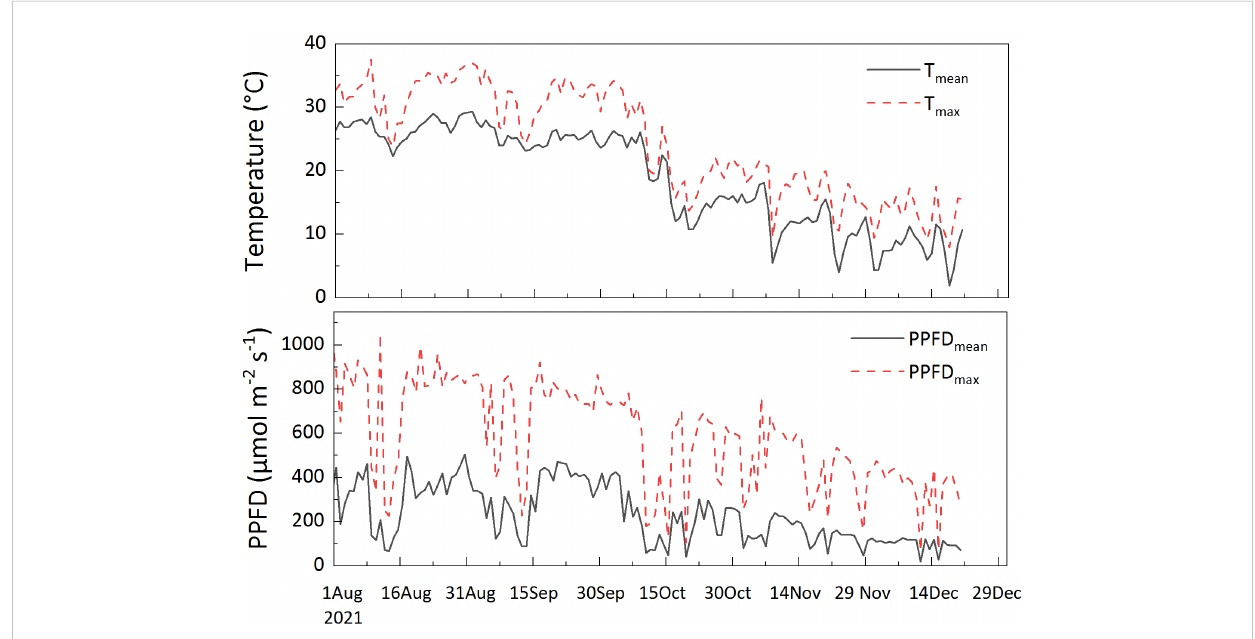
FIGURE 1 Diurnal (6:00-18:00) mean temperature (T mean ), maximum temperature (T max ), diurnal mean temperature (PPFD mean ) and maximum photosynthetic photon fl ux density (PPFD max ) during the experiment. The meteorological data were collected from a micrometeorological station in an open foothills area. The direct distance to the study plots was approximately 200 m. The station monitored radiation (MJ m -2 ; LI200X, Campbell, USA), and air temperature (Campbell,